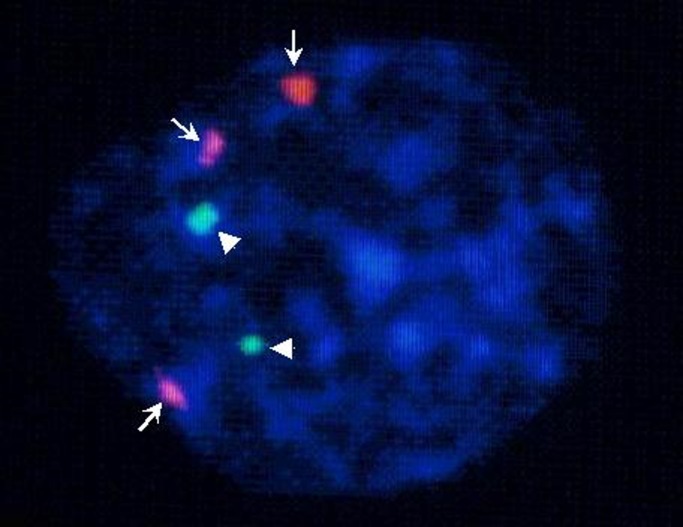
Polysomy of chromosome 4 and DKK2 deletion in a HCC case.The arrow indicates hybridization signals from a centromeric probe for chromosome 4. The arrowhead indicates hybridization signals from a 4q21 YAC probe. Note that there are three signals from the centromere but only two for 4q21.